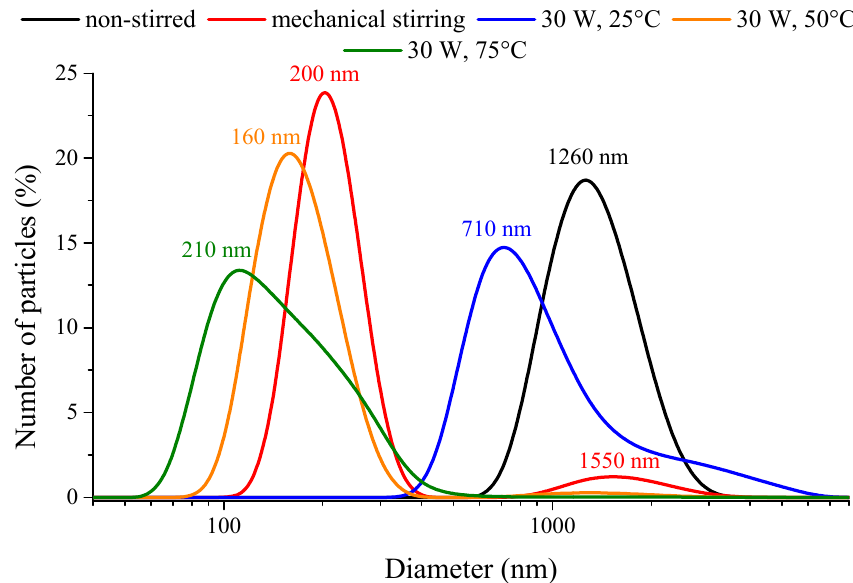
Figure 3. Number-based size distribution curves of the nickel nanoparticles prepared without stirring (25 °C), with mechanical stirring (25 °C) and under ultrasonic treatment (30 W output power, continuous sonication) at various temperatures.